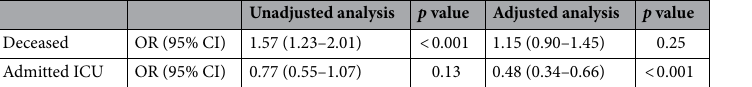
Table 3. Odds ratio (OR) and 95% confidence interval are reported for logit regression, incidence rate ratios (IRR) and 95% confidence interval for Poisson